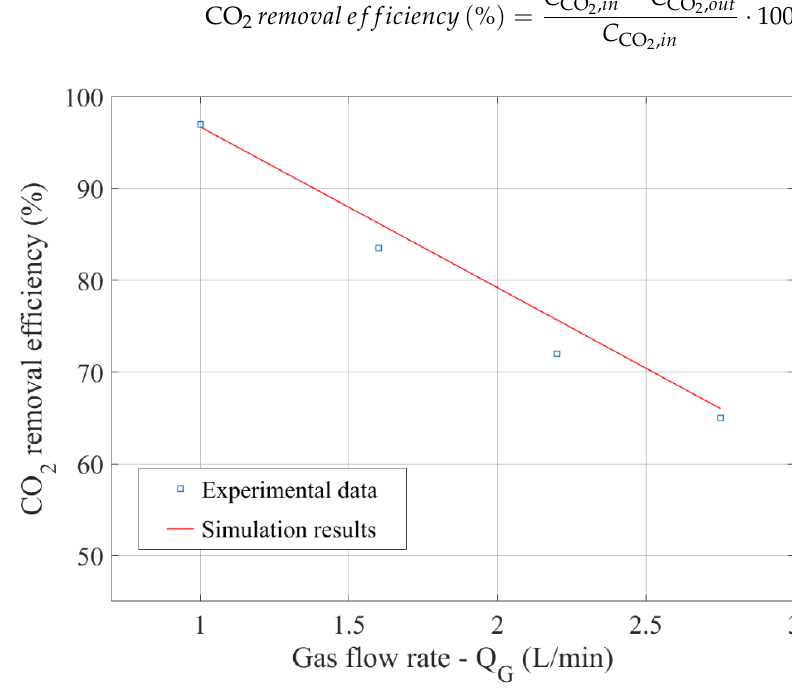
Figure 5. CO 2 removal efficiency at different gas flow rates, Q L = 25L · h − 1 .